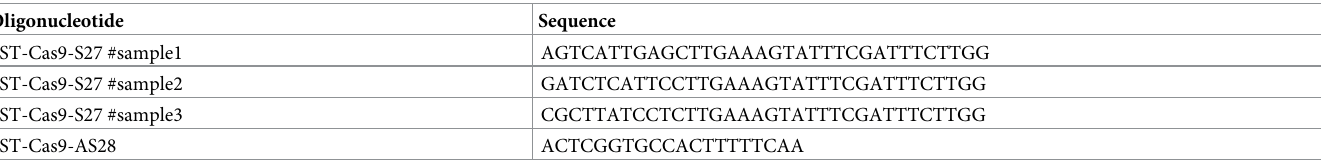
Table 1. Oligonucelotides used in this study.